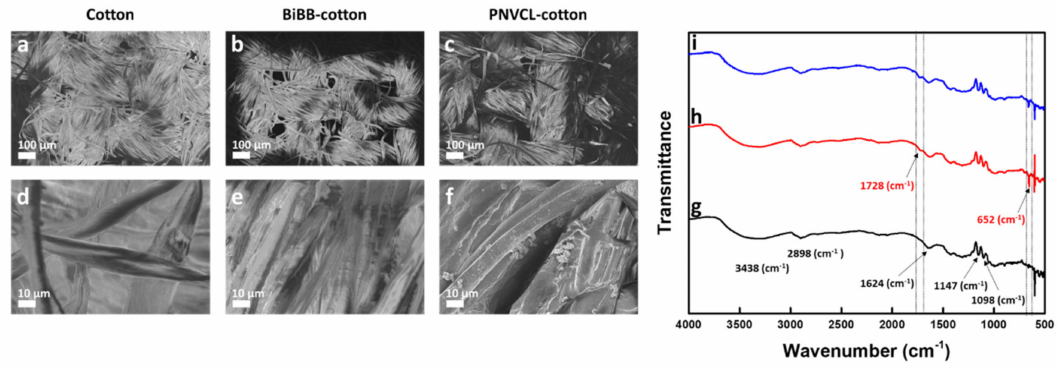
Figure 3. ( a – f ) SEM images of the ( a , d ) cotton, ( b , e ) cotton-BiBB, and ( c , f ) cotton-PNVCL fabrics; top images magnified 100 × ; bottom images magnified 1000 × . ( g – i ) Fourier transform infrared (FTIR) spectra of the ( g ) cotton, ( h ) cotton-BiBB, and ( i ) cotton-PNVC